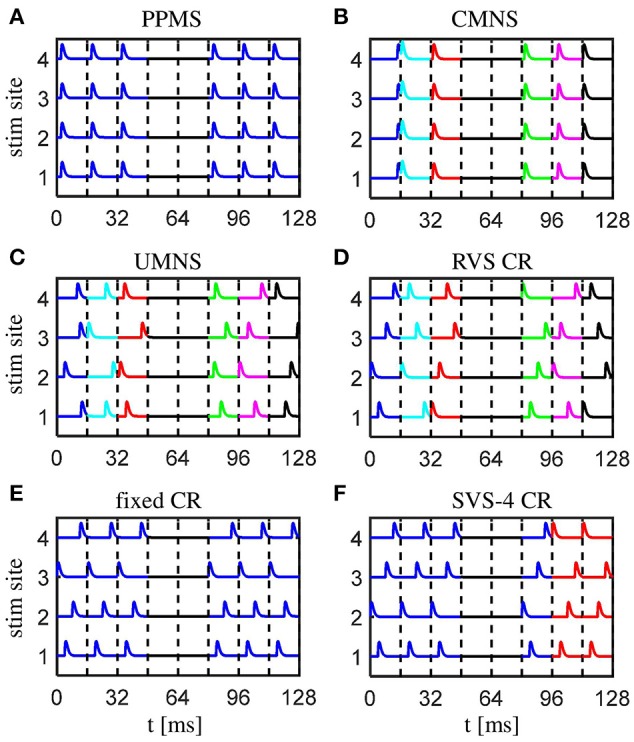
Schematic of the spatio-temporally patterned stimulation protocols as used in this study. (A) The purely period multichannel stimulation (PPMS) simultaneously activates all stimulation sites at the same time instance within each stimulation ON-cycle. (B) The correlated multichannel noisy stimulation (CMNS) activates all stimulation sites simultaneously, but at different, random time instances, equally distributed within each stimulation ON-cycle. (C) The uncorrelated multichannel noisy stimulation (UMNS) activates the stimulation sites sequentially in a random order at different time instances within different stimulation ON-cycles. Stimulation onsets are equally distributed within each stimulation ON-cycle, where the random processes for the different channels are uncorrelated. (D) The rapidly varying sequences (RVS) CR stimulation activates the stimulation sites in a random temporal order at times n · Ts/4 (n ∈ {0, 1, 2, 3}) within each stimulation ON-cycles. (E) The fixed CR stimulation approach employs a fixed sequence during the entire CR-on period, and stimulation onsets times within the stimulation ON-cycles are at multiples of n · Ts/4 (n ∈ {0, 1, 2, 3}). (F) In this example, for the sake of illustration, the slowly varying sequences (SVS) CR stimulation repeats the first sequence four times, before a new sequence is drawn. Different stimulation sequences are randomly drawn with equal probability. For the remainder of this study each sequence is repeated 100 times and not just four times (SVS-100 instead of SVS-4). Stimulation onsets are as for the RVS CR at n · Ts/4 (n ∈ {0, 1, 2, 3}) within the stimulation ON-cycles. All stimulation protocols have four equidistantly distributed stimulation sites, stimulation ON- and OFF- cycles of 16 ms, a total stimulation on period of 128 s, in which three ON-cycles are alternated by two OFF-cycles. No stimulation is applied during OFF-cycles. Stimulation ON- and OFF-cycles are separated by dashed vertical lines. A change of color indicates a change of the pattern of stimulus onsets compared to the previous ON-cycle.